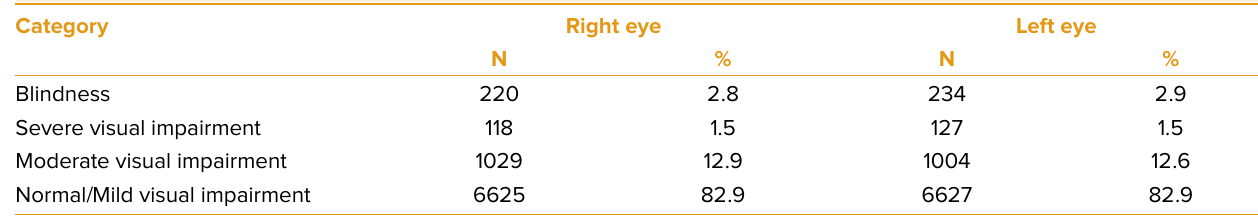
Table 1. Characterization of visual acuity per eye in patients aged 50 years and over, Honduras 2018–2019 ( N : 7992)